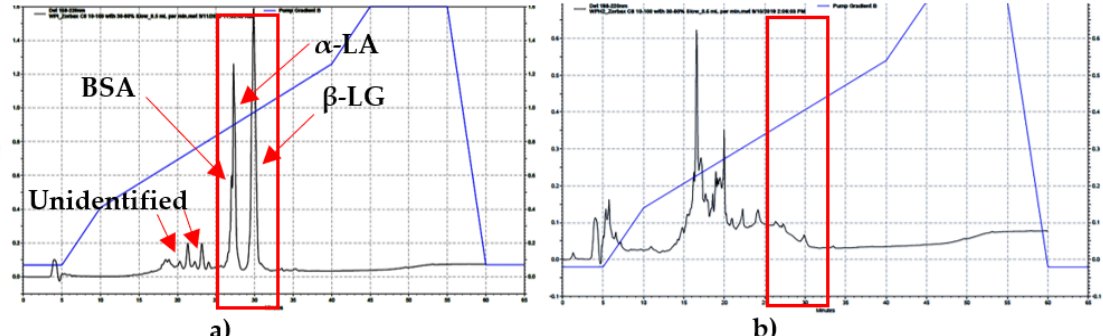
Figure 2. ( a ) The RP-HPLC chromatogram of WPI shows the major WPs in the unhydrolyzed sample; ( b ) The RP-HPLC chromatogram of WPH. No peaks were observed at the times of 26.3, 27.2, 29.9 min, indicating a complete hydrolysis of the major WPs in WPH samples.